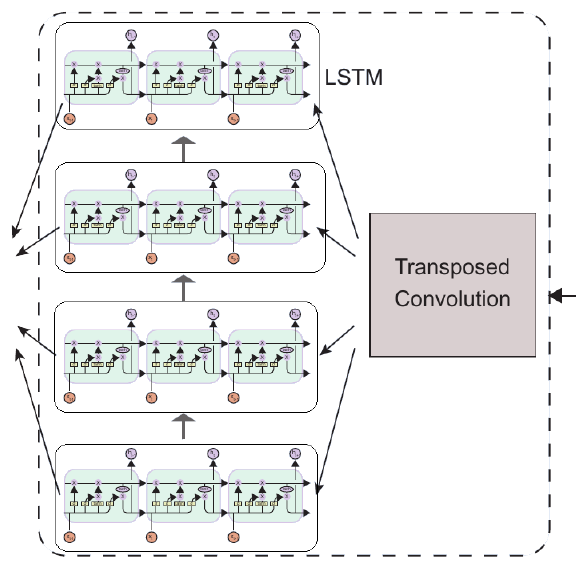
Figure 4. The RethinkNet